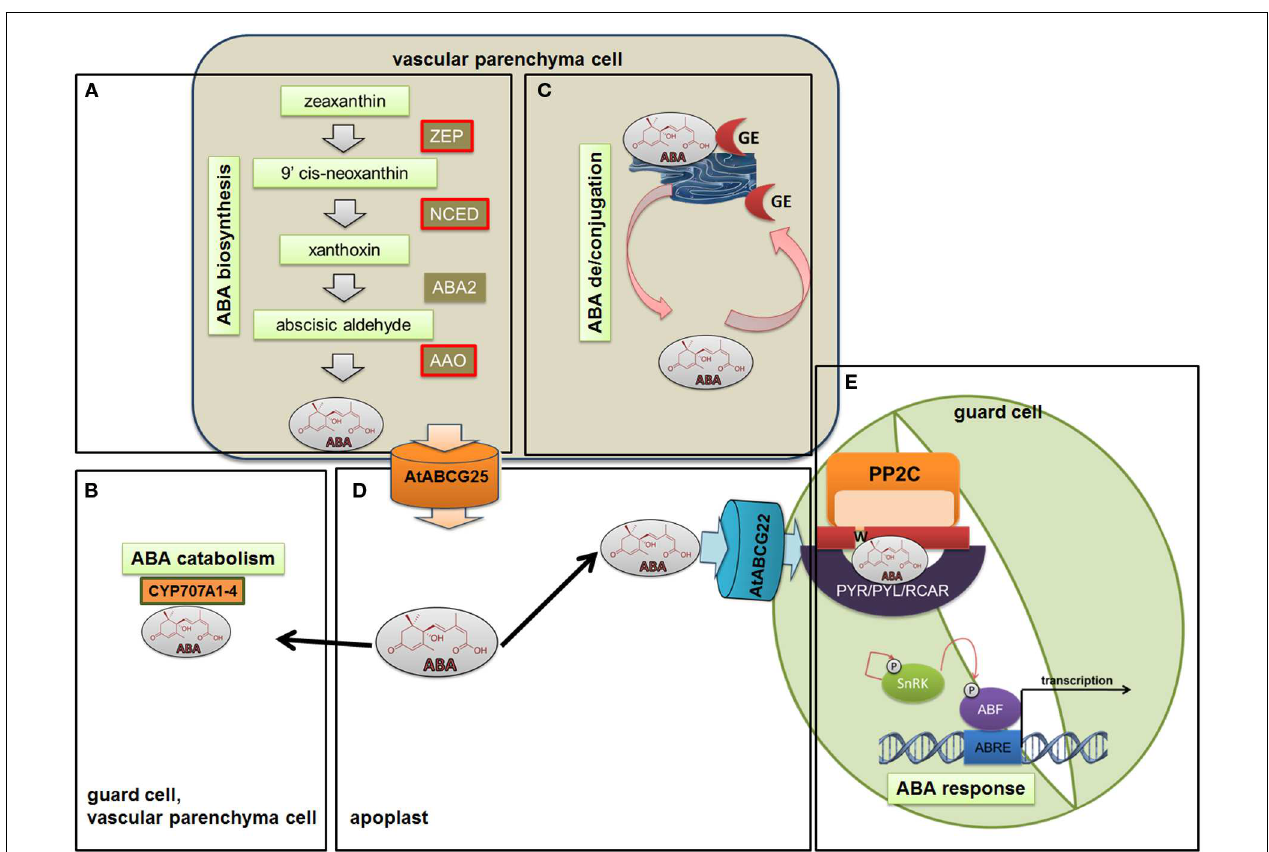
is the ABA glucosyl ester (ABA-GE), which is catalyzed by ABA glucosyltransferase (C) . ABA delivery to the guard cells via ABCG transporters such as AGCG22 (D) promotes a cascade of reactions.The core of early ABA signaling involves ABA receptors – PYR/PYL/RCAR proteins, PP2Cs, and SnRKs (E) . After binding ABA to the receptor, the negative regulatory action of PP2Cs is inhibited and SnRKs are able to phosphorylate and activate downstream targets in order to transduce the ABA